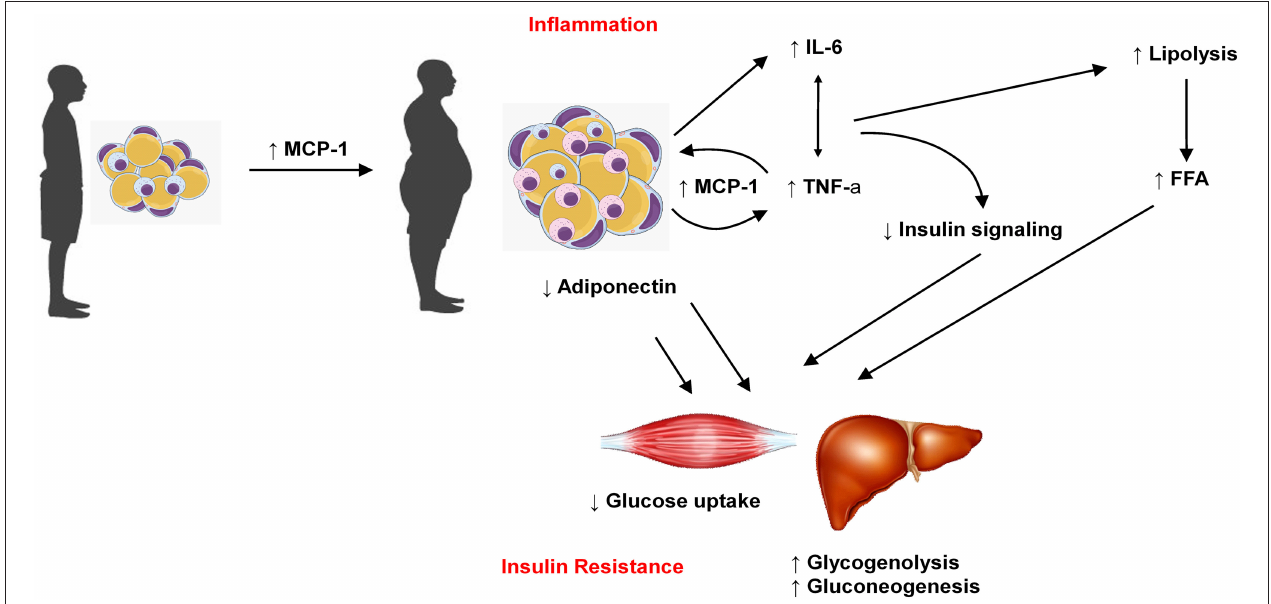
FIGURE 2 | Increase in adipose tissue mass is related to increase in MCP-1, which favors macrophages migration to adipose tissue and the production of other adipokines such as IL-6 and TNF α . On the other hand, obese adipose tissue produces less adiponectin. Taken together, these features reduce glucose uptake in muscle cells and favors glycogenolisis and gluconeogenesis in liver, which contribute to insulin resistance and